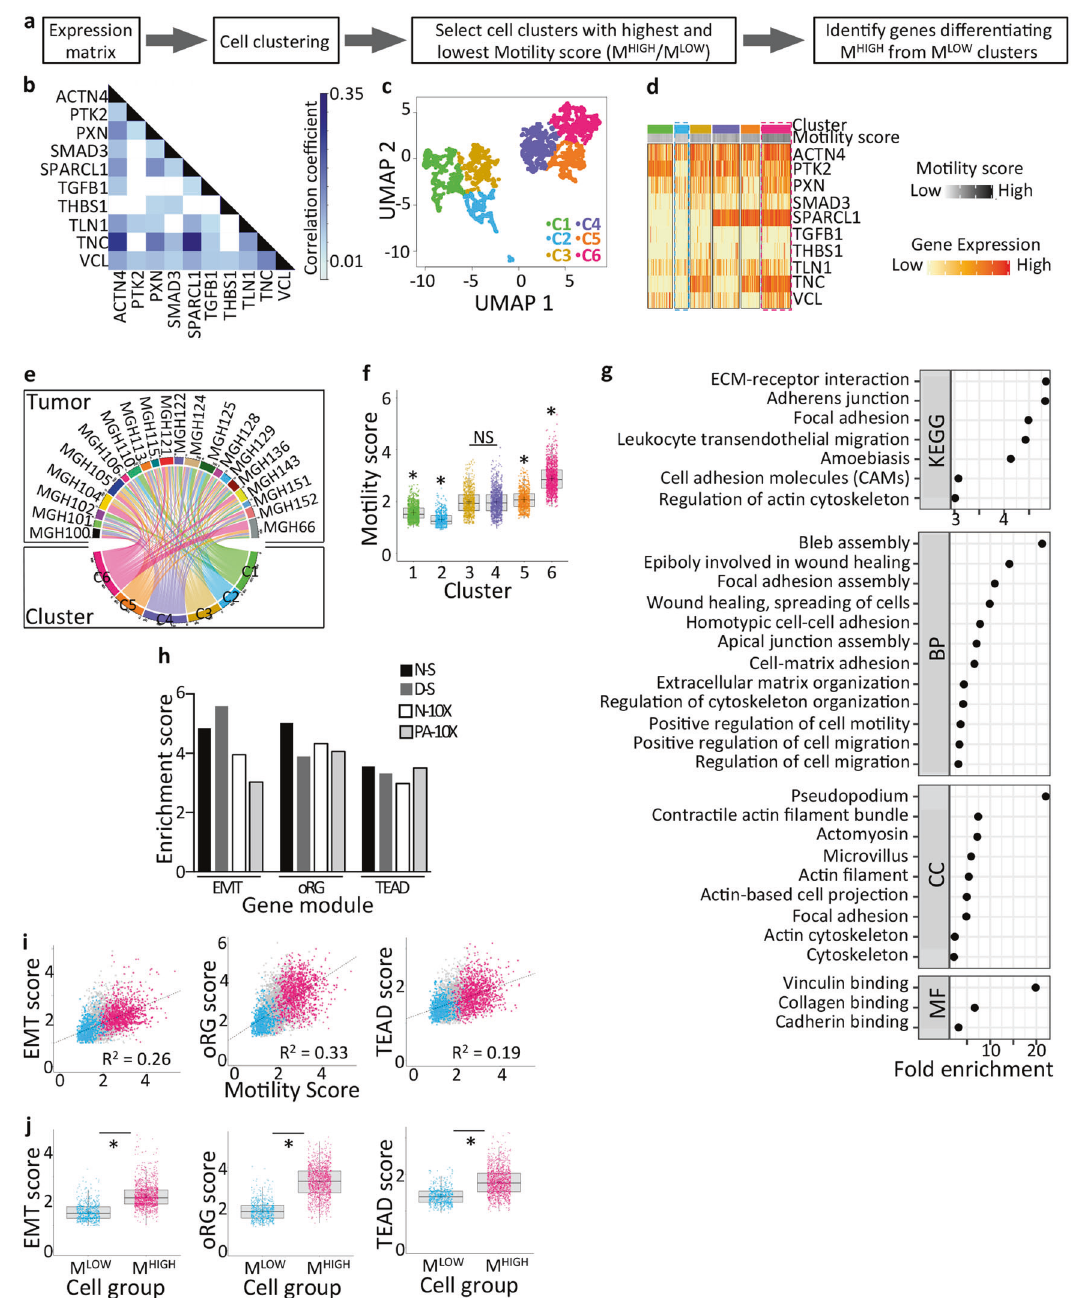
Fig. 1 Grouping GB cells from distinct patients according to their motility potential. a Schematic outline of the computational analytical strategy. b Signi fi cant correlations between expressions of the ten genes of the motility signature ( p < 0.01). c Malignant cell clustering based on the motility signature. d Different combinatorial expressions of the signature genes characterize each cluster. e Each cell cluster contains cells coming from distinct tumors (NMI Score = 0.11). f Identi fi cation of cell groups with the highest and lowest mean motility scores (C6: M HIGH , C2: M LOW ). *Clusters statistically different from each of the other clusters, p -value < 0.01, one-way ANOVA, Tukey ’ s multiple comparisons test. NS: non-signi fi cant. g Motility-related terms highlighted by ontology analysis of genes overexpressed in M HIGH versus M LOW cells. Genes overexpressed with fold change ≥ 2. BH-adjusted p -value < 0.05. BP biological processes, CC cellular components, MF molecular functions. h Enrichment in EMT, oRG, and TEAD gene modules previously associated with GB cell motility in M HIGH cells. p < 0.001, hypergeometric test. i Linear regression model between motility score and EMT, oRG and TEAD scores. p < 0.0001. j Higher EMT, oRG and TEAD scores in M HIGH versus M LOW cells. * p < 0.0001, Mann – Whitney test. b – g , i , j : N-S dataset analysis. See also Figs. S1 – 5 and Tables S1 –